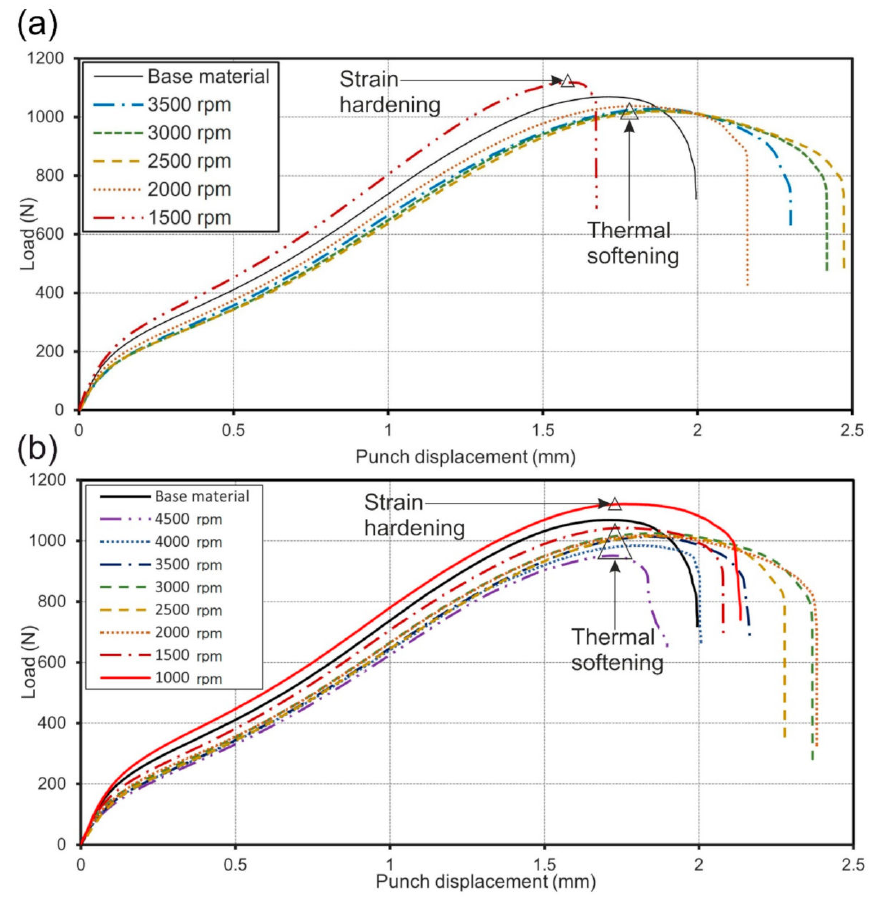
Figure 13. The load-displacement curves comparing the base material and weld specimens obtained with a small punch test (SPT): ( a ) batch I (1500 to 3500 rpm); ( b ) batch II (1500 to 4000